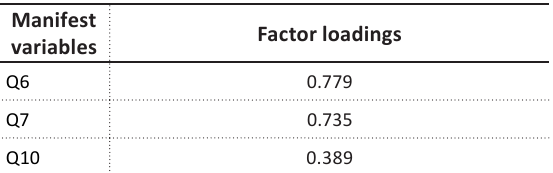
Table 10. Millennials feel that the brands should add their business voice to socio-cultural, political and environmental